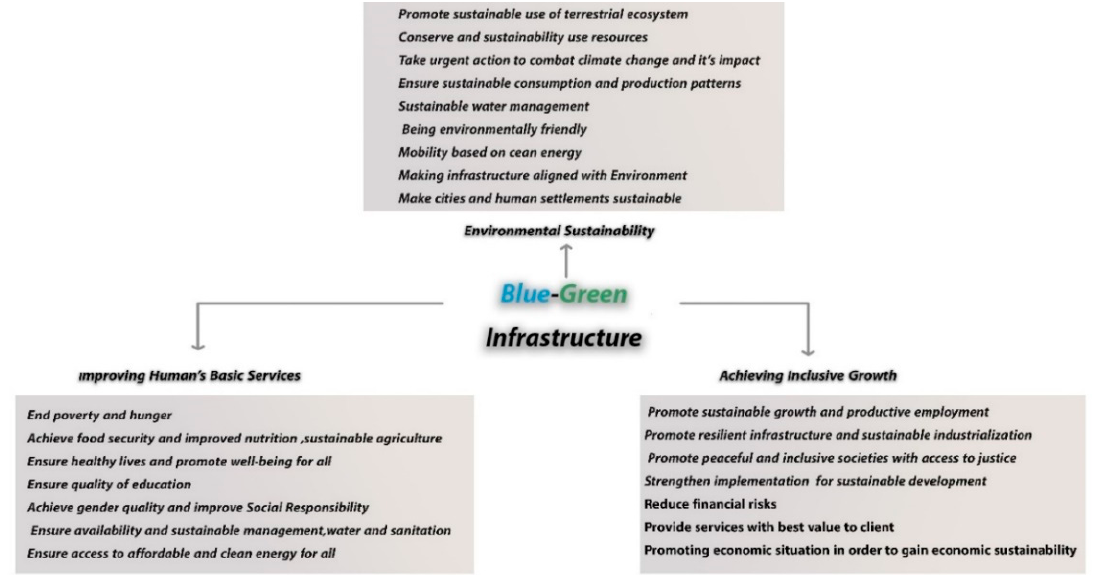
Figure 6. Blue-Green Infrastructure (Authors, [43]).